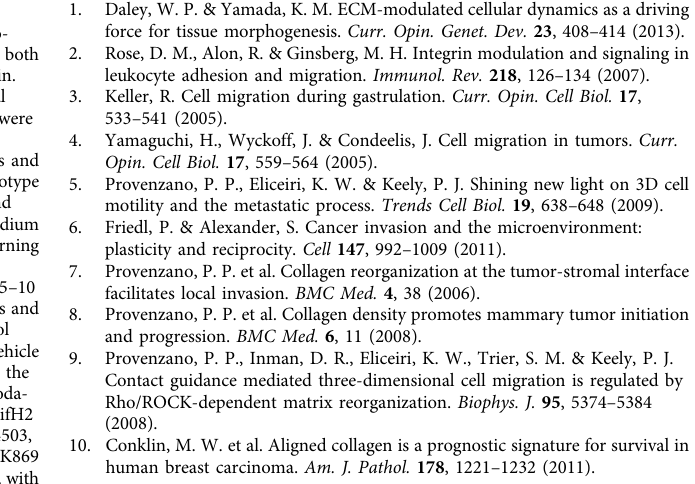
Fig. 1. Poorly spread cells were measured only if they developed minimal pro- trusions along either axis. Cell edge curvature radii were measured by fi nding corresponding cell-edge-conforming circles with the three-points method as shown in Fig. 1. Cell traction forces analysis . For tracking deformation in PAA gels 11 during TFM analysis, we modi fi ed patterned PAA platforms by adding 0.2µm fl uorescent were taken with live confocal laser scanning at the interface planes between cells and the adhesion ligand patterns. Live cell imaging was performed in a